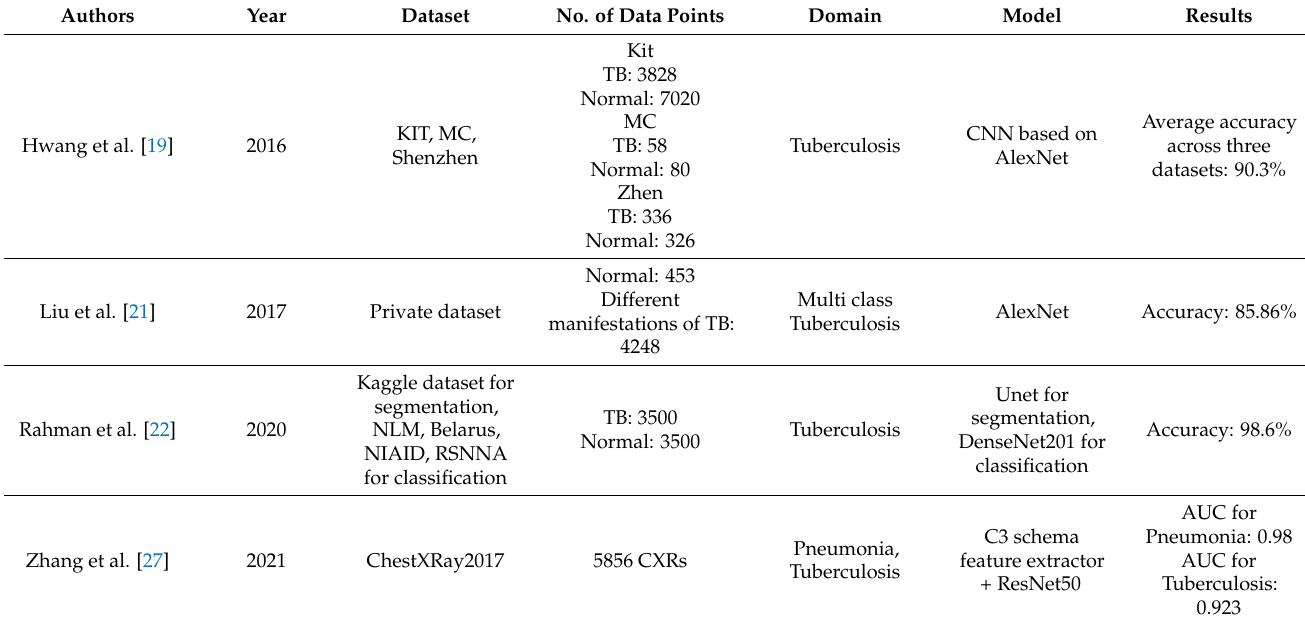
Table 2. Summary of work using deep learning for Tuberculosis classification through